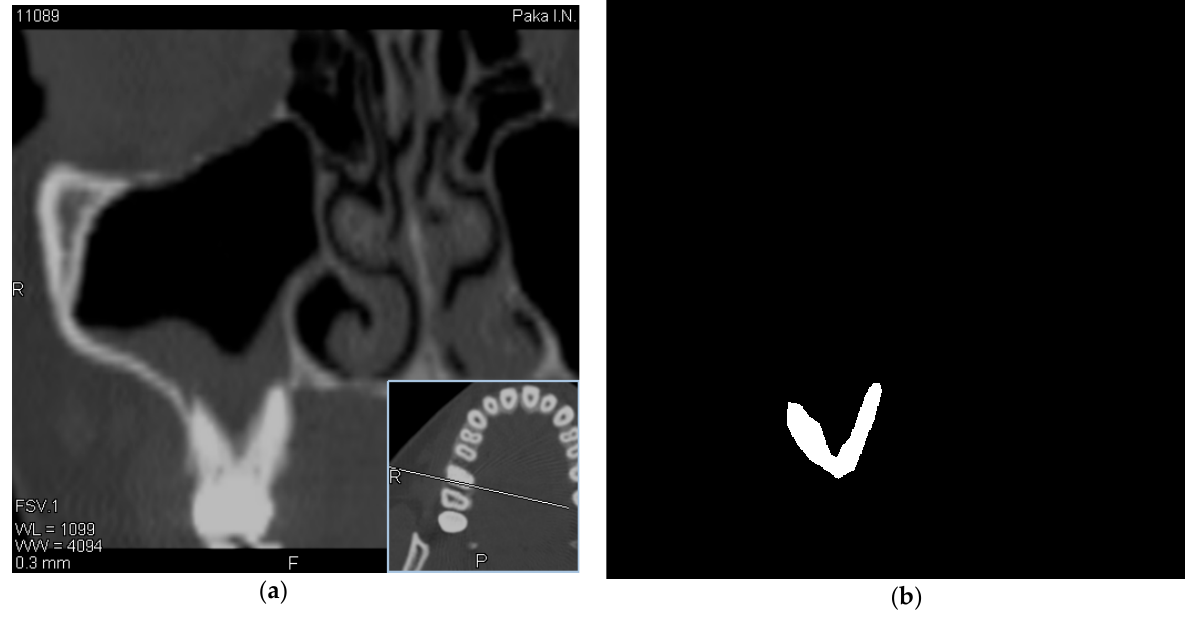
Figure 1. Sample CT image and its manual segmentation label ( a )—initial image, ( b )—mask created by expert.